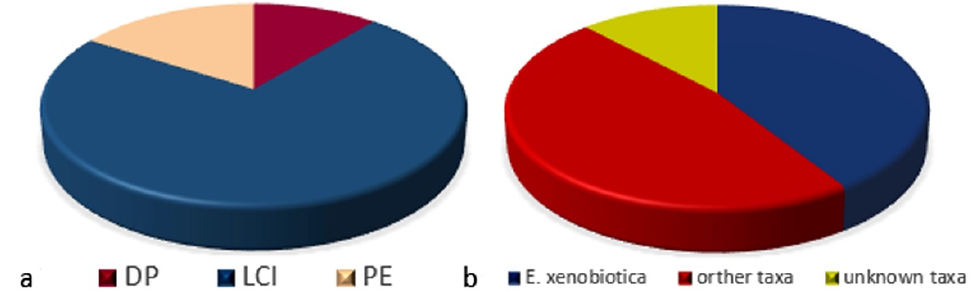
Figure 3. General results based on the 181 isolated strains: ( a ) isolation yields by method: LCI: long cold incubation, DP: direct plating, and PE: phenolic enrichment; ( b ) prevalence of E. xenobiotica compared to other known and unknown taxa. Most of the 181 black fungal isolates were identified at the species level (Table 1). Exophiala xenobiotica was the most frequent isolated species (Figure 3b), while 12% of the isolates represented novel fungal taxa. The isolation frequencies in the three niches under investigation were used for the subsequent biodiversity analysis. Table 1. List of the 181 isolated strains. The identifications were performed by BLASTn comparison and ML ITS-based trees (Figures S3–S6). The taxonomic novelties found were identified at the genus or family level.